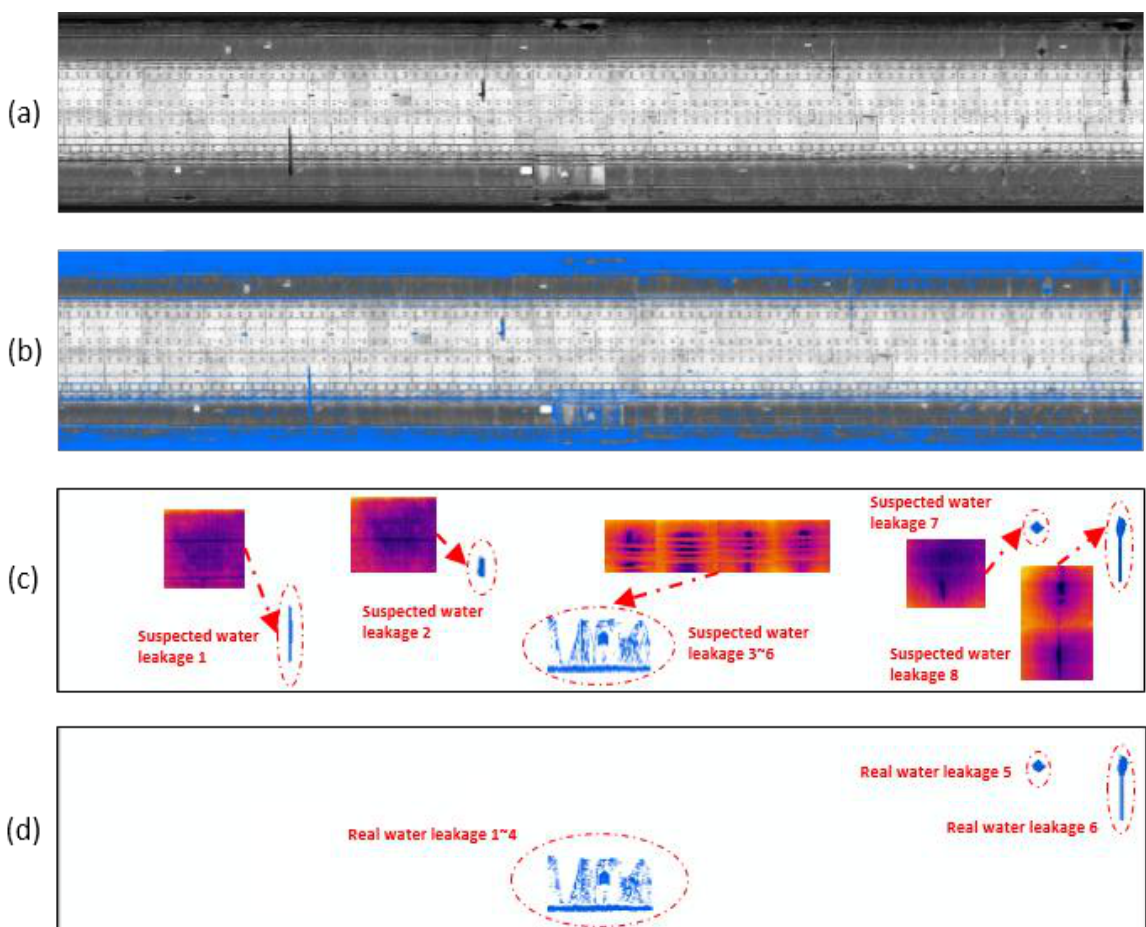
Figure 5. The extraction result of water leakage geometry information. (a) Intensity Image of Tunnel, (b) Threshold Segmentation Results Based on Point Cloud Intensity. (c) Extraction of Suspected Water Leakage & Misjudgement Filter. (d) Extraction of